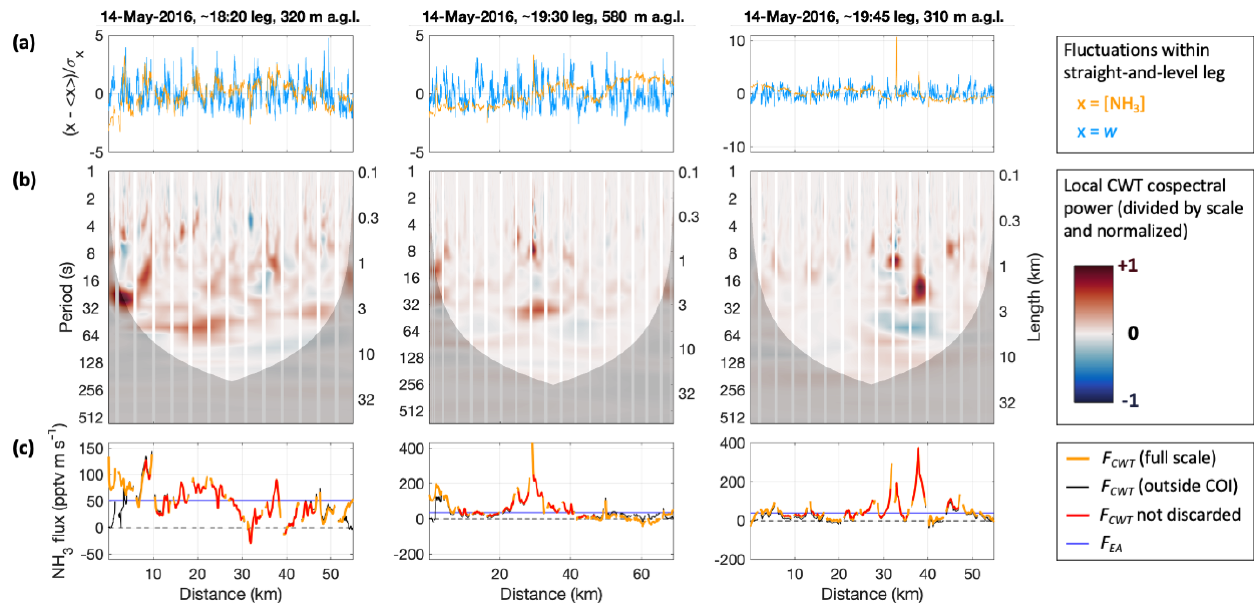
Figure 7. Continuous wavelet transform (CWT) analysis of the covariance between vertical wind ( w ) and NH 3 mixing ratio ([NH 3 ]) for the three selected straight-and-level legs in three columns. Panels in each column share the same abscissa, representing distance along the respective leg. The regular gaps in the data are the zero measurements by the CIMS. Panel (a) shows the normalized time series, i.e., fluctuations around the leg’s mean. Panel (b) presents local co-spectral powers as surface plots, following scale bias correction and normalization; reds for positive (upward) power, blues for negative (downward) power. The darkened lower parts represent the “cone of influence” (COI) that marks the locations and scales where co-spectral power may be subject to edge effects. Scales are expressed as periods (left ordinate) and lengths (right ordinate); periods correspond to lengths as per the aircraft’s ground speed (90–98ms − 1 ). Panel (c) shows the resulting flux values, F CWT , orange for the full-scale averages, thin black for averages outside the COI only, and red for the data passing the conservatively chosen quality criteria. For comparison the ensemble-average covariance, F EA , is shown in